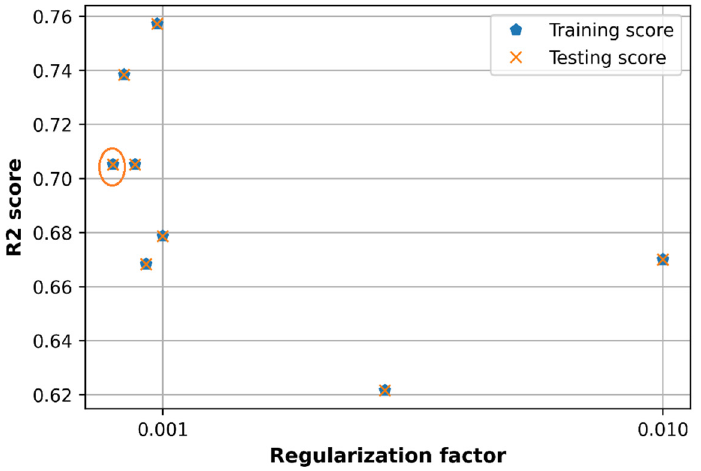
Figure 20. Comparison of accuracy with different regularization factor.